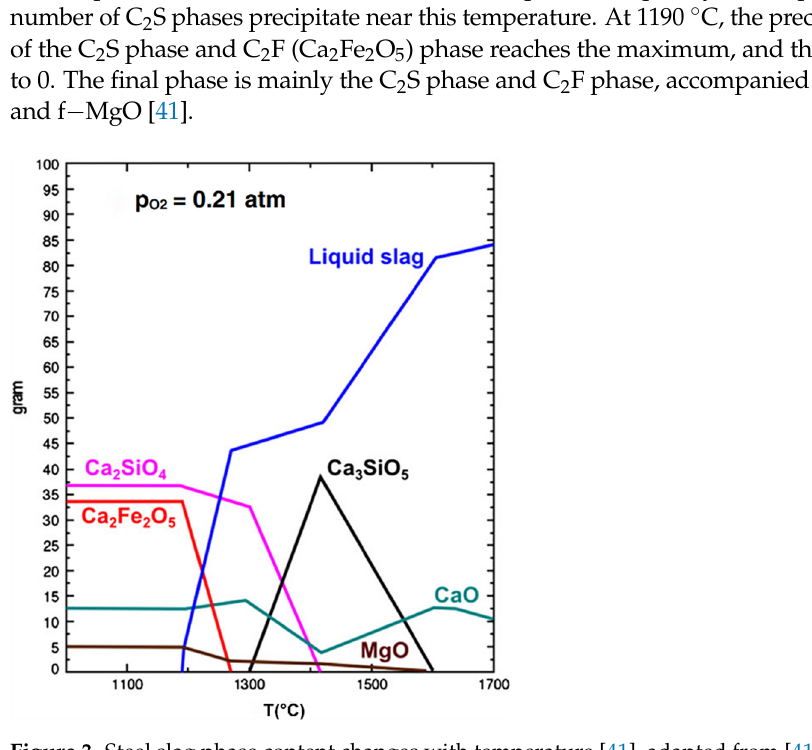
Figure 2. A conceptual carbonation model diagram of the γ − C 2 S particle [37], adapted from [37], with permission from Elsevier, 2021.